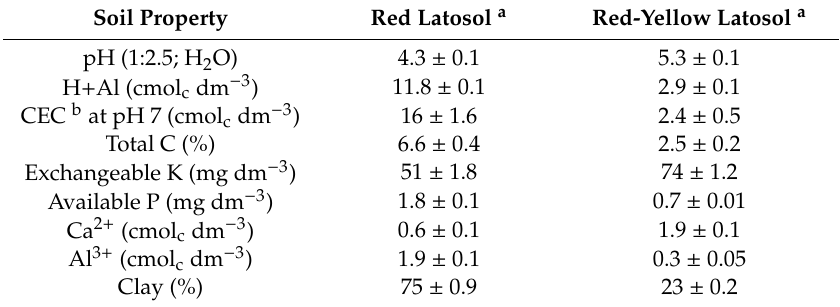
Table 1. Chemical and physicochemical properties of the dystrophic Red Latosol (RL) and Red-Yellow Latosol (RYL)